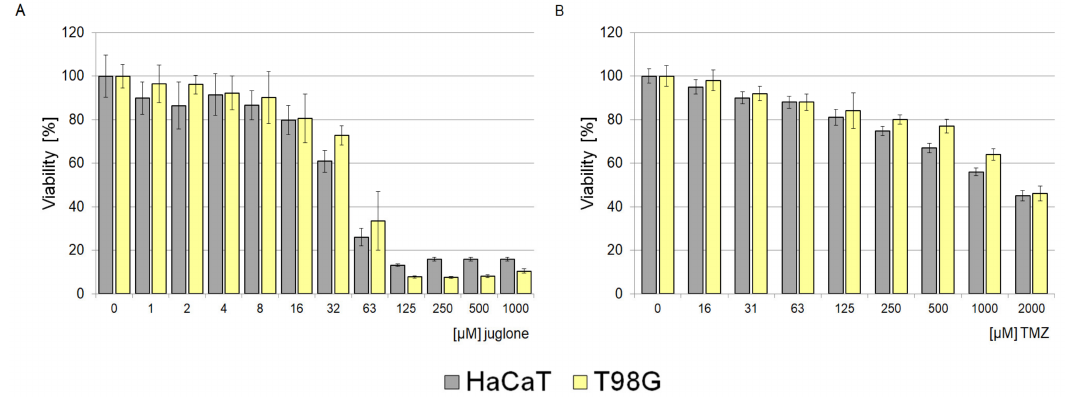
Figure 3. Cytotoxicity of juglone ( A ) and TMZ ( B ) effect on human keratinocyte (HaCaT), glioblas- toma (T98G) cell lines. The cells were treated with 1–1000 µ M of juglone and 1–2000 µ M of TMZ for 24 h. Cell viability was determined using the MTT